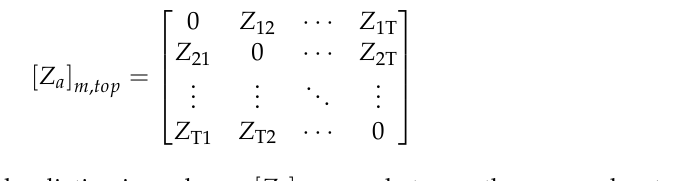
Figure 8. Sound radiation by an X × Y array of cymbal transducers with dual radiation surfaces. If the total number of cymbal transducers constituting the array is T, the dual-source array can be regarded as consisting of 2T sources. The mutual radiation impedance [ Z ] between the sound sources located at the top surface of the array can be expressed a m , top as Equation (5). Each element of the impedance matrix is obtained using Equation